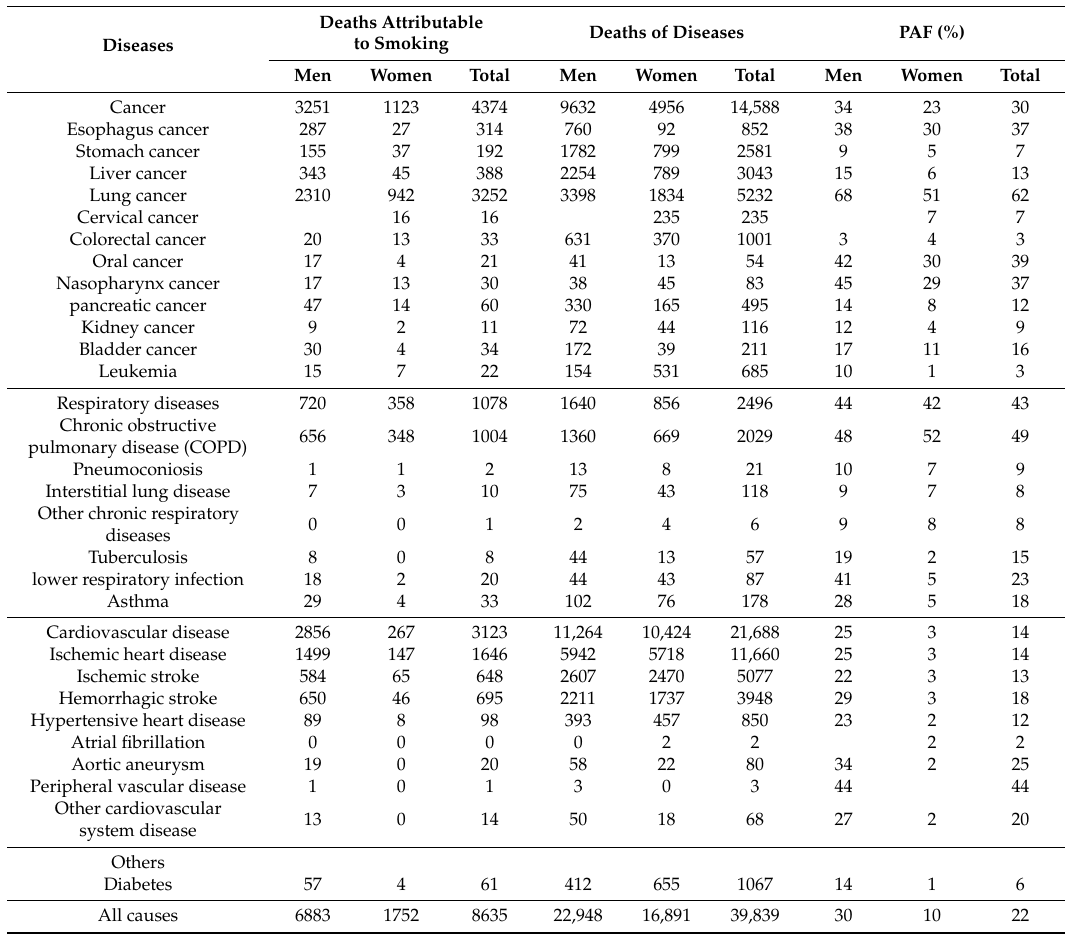
Table 2. Number of deaths attributable to smoking and population-attributable fractions (PAF) of diseases by